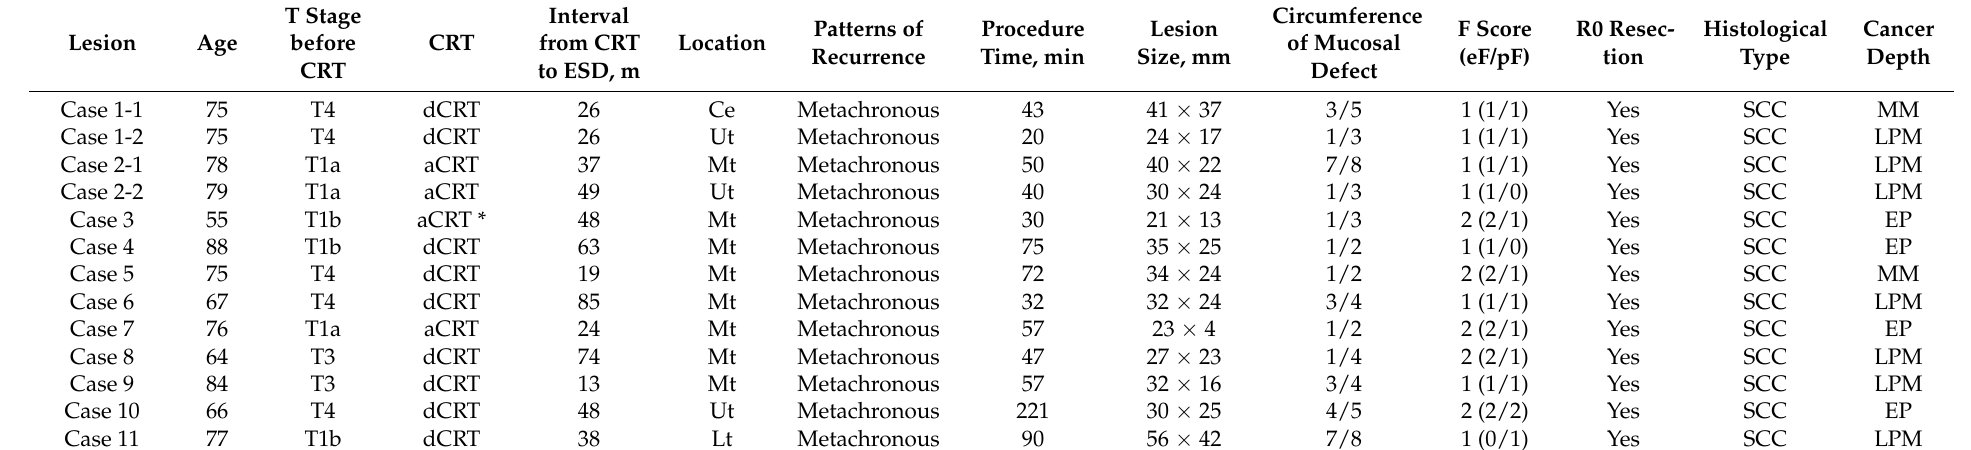
Table 1. Patient characteristics and ESD